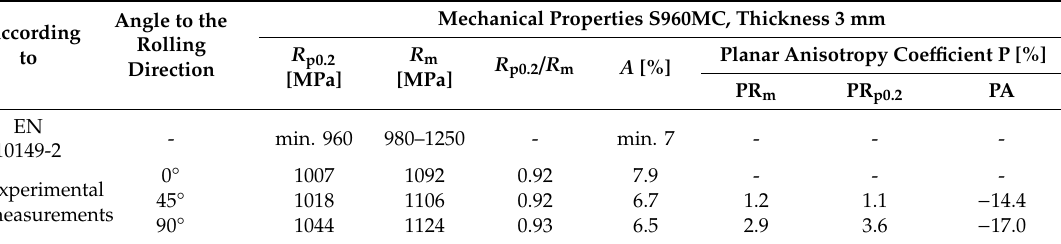
Table 2. Mechanical properties of investigated steel.